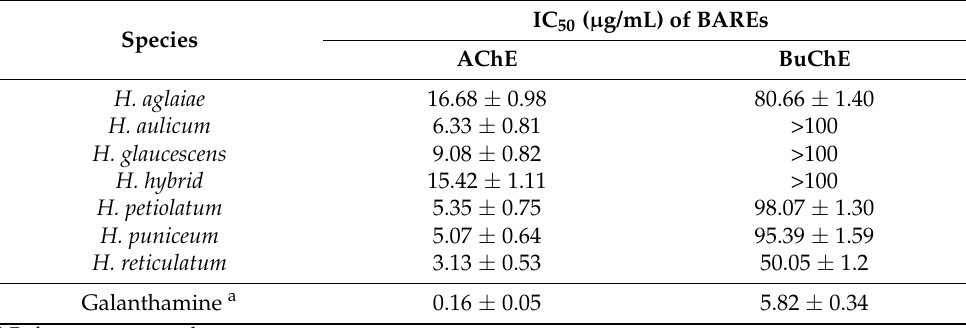
Table 2. Cholinesterase inhibitory activities of Argentinean Hippeastrum spp.